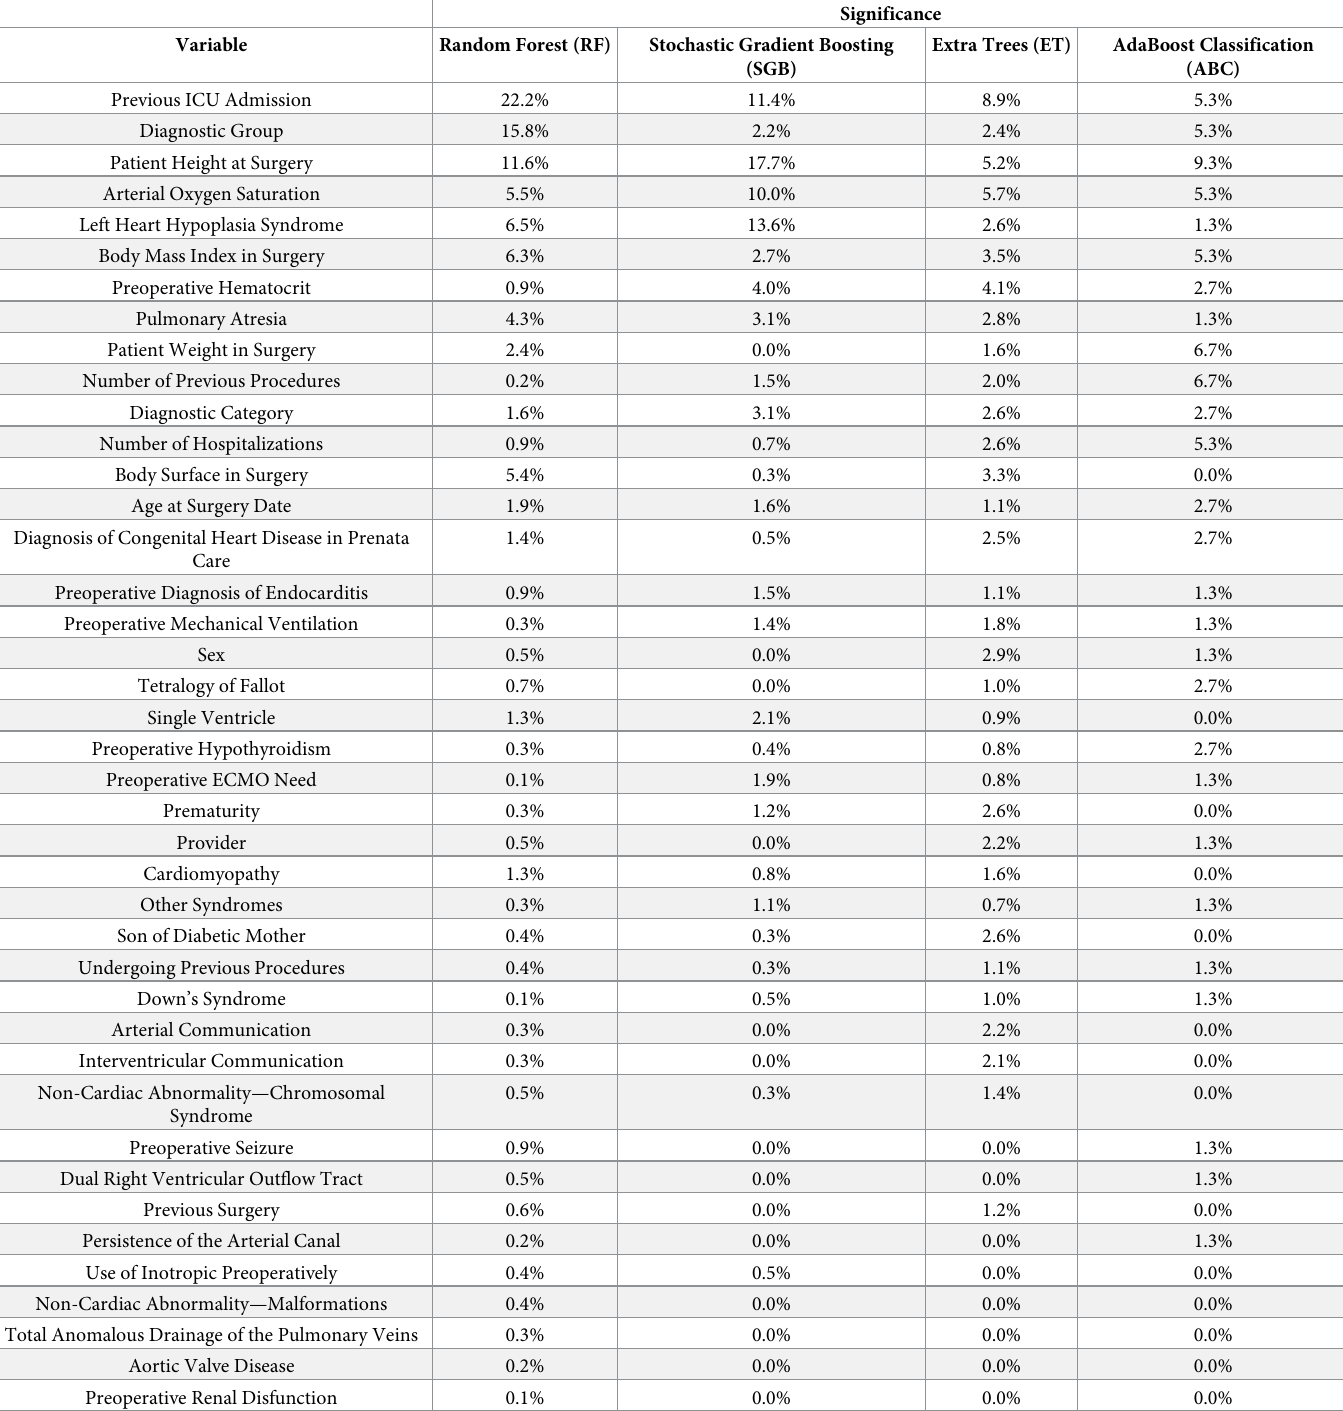
Table 4. Importance of predictor variables in the